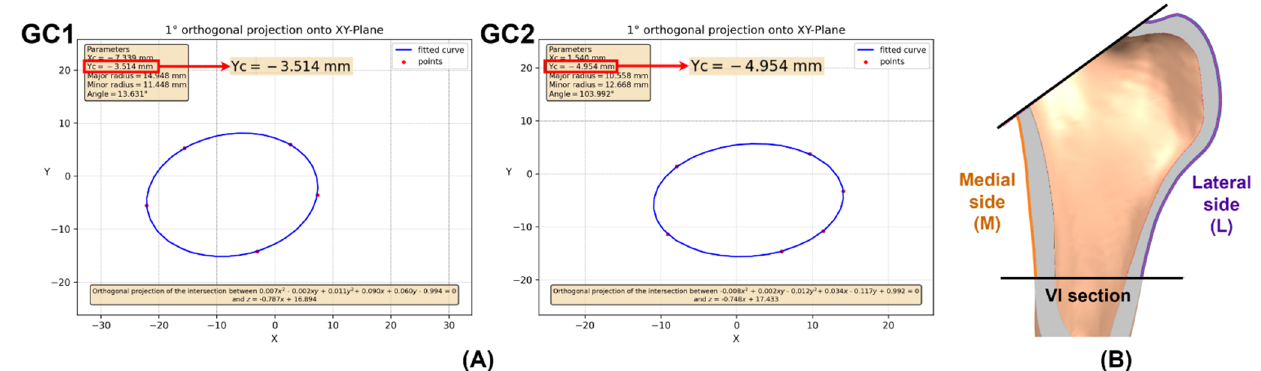
Figure 11. ( A ) Elliptical adjustment of the implantation section. ( B ) Medial and lateral side of the proximal femur.